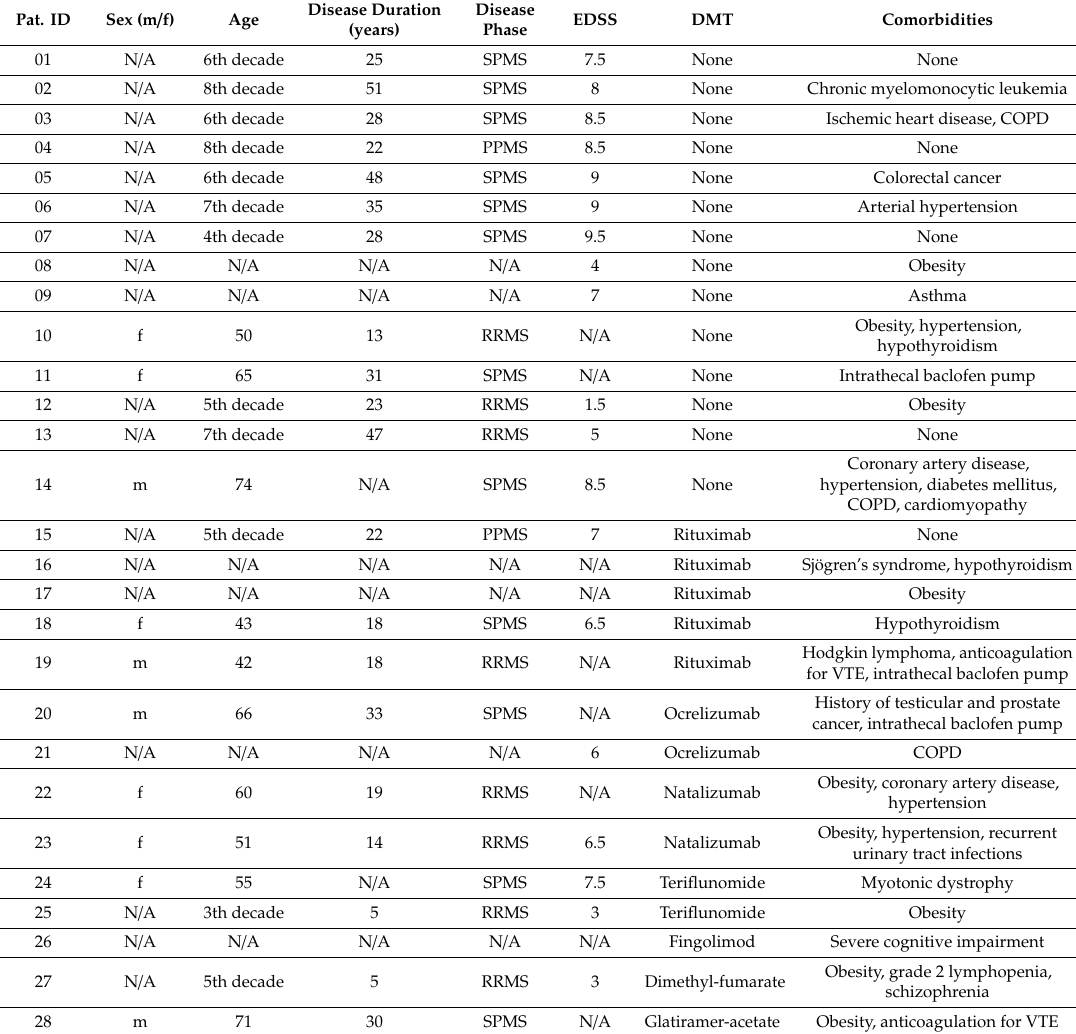
Table 1. Characteristics of deceased SARS-CoV-2 positive MS patients. BMI: body-mass-index; COPD: chronic obstructive pulmonary disease; DMT: disease modifying therapy; EDSS: Expanded Disability Status Scale; f: female; m: male; N / A: not available; PPMS: primary progressive multiple sclerosis; RRMS: relapsing-remitting multiple sclerosis; SPMS: secondary progressive multiple sclerosis; VTE: venous